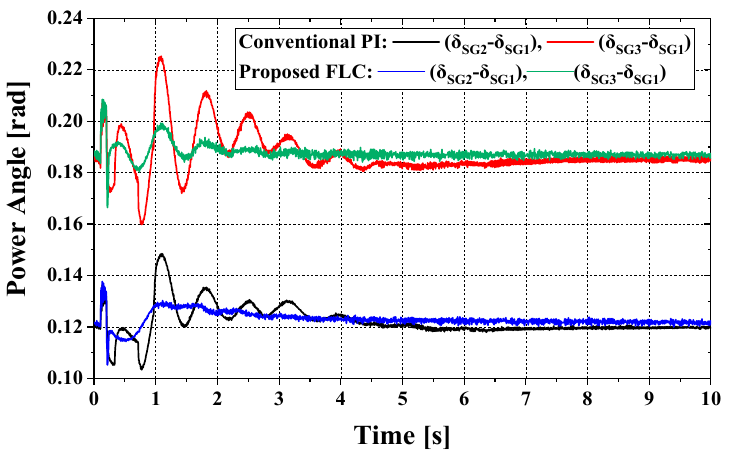
Figure 13. Active power profile of the SGs.